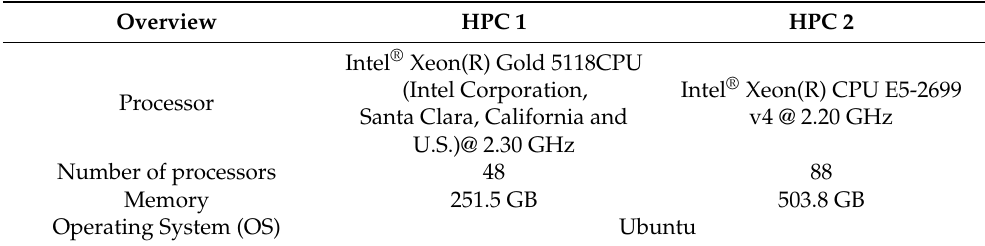
Table 9. Characteristics of the HPCs.